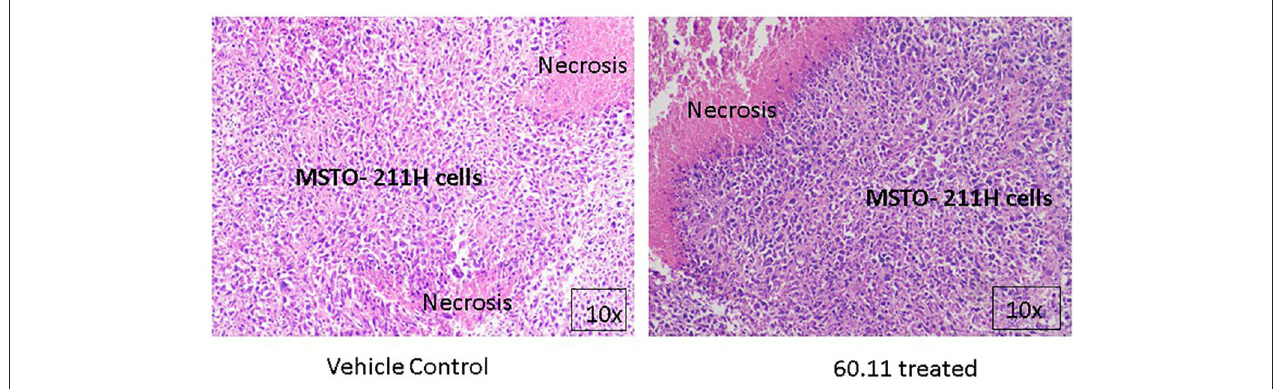
FIGURE 5 | MSTO-211H tumors resected from control and 60.11 treated mice are histologically similar. Representative histologic (10 × ) images of tumors stained with hematoxylin and eosin show tightly packed MSTO-211H cells and areas of necrosis. No histologic differences in tumor morphology were apparent between control and treatment groups.